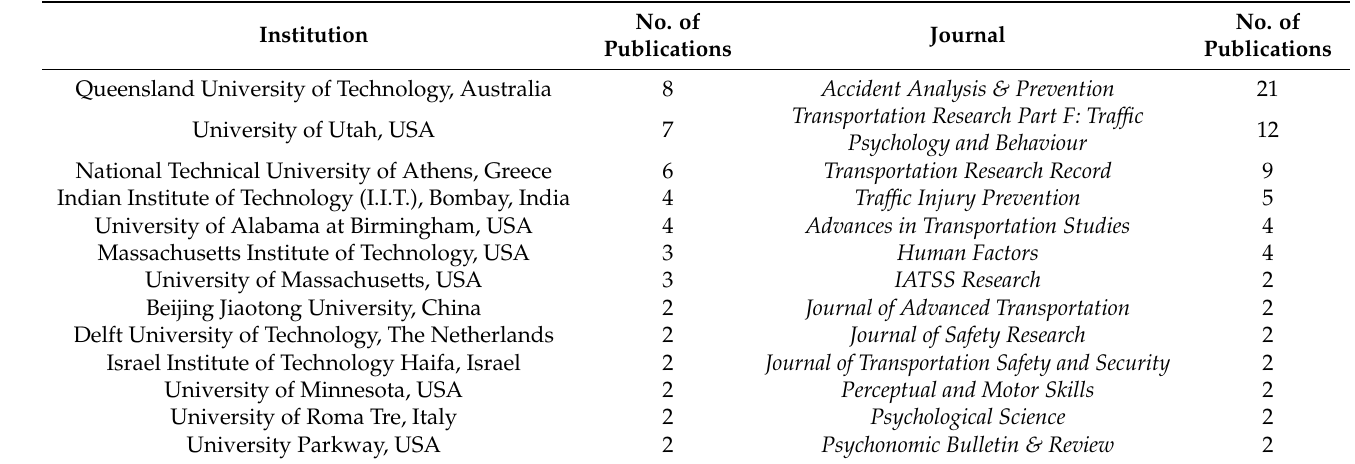
Table 2. Distribution of papers by research institution and by journals.